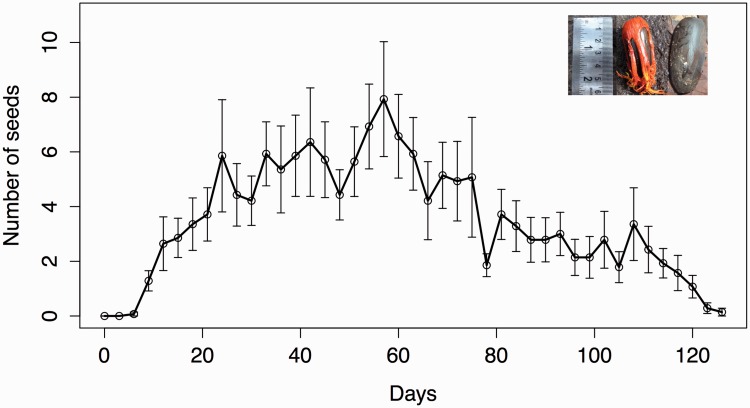
Number of seeds dispersed via frugivores and those passively detached from M. fatua trees over the fruiting months (28 May to 31 September, 2013). The error bars indicate SE values. Inset shows an aril-intact seed (non-dispersed) and an aril-removed (dispersed) seed.